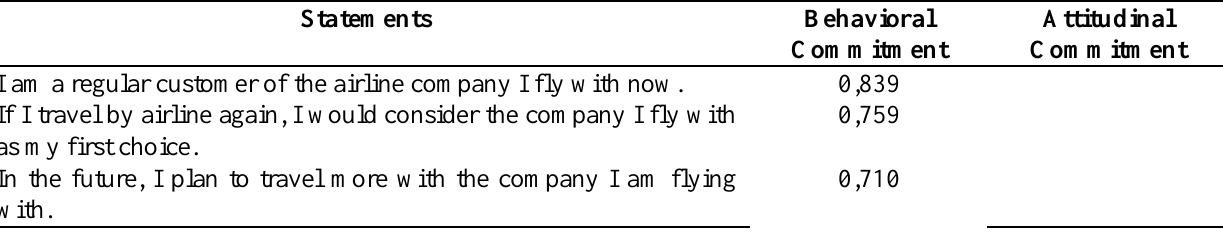
Table 5. Factor analysis of customer loyalty